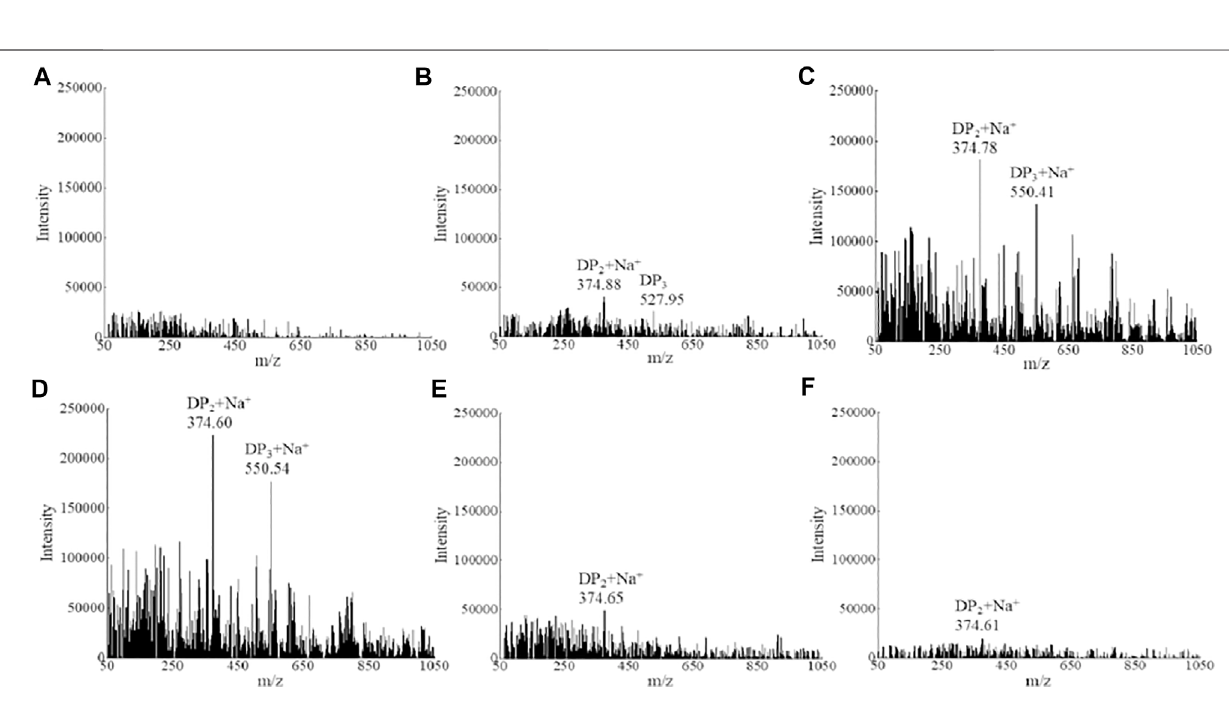
Frontiers in Bioengineering and Biotechnology |